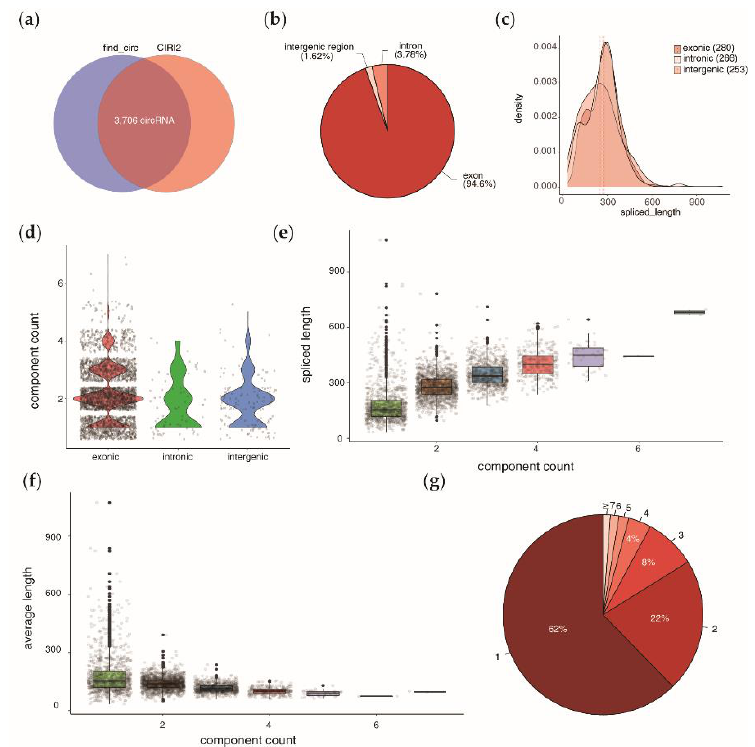
Figure 2. Genomic feature characterization of circular RNAs from goat DPCs and DFs. ( a ) The counts of circRNAs detected by both tools; ( b ) The proportion of each type of circRNAs; ( c ) The length distribution and average length of circRNAs; ( d ) Component counts distribution of circRNAs; ( e , f ) The spliced length and average length of circRNAs with different component counts; ( g ) The percentage of genes producing one or more circRNAs.